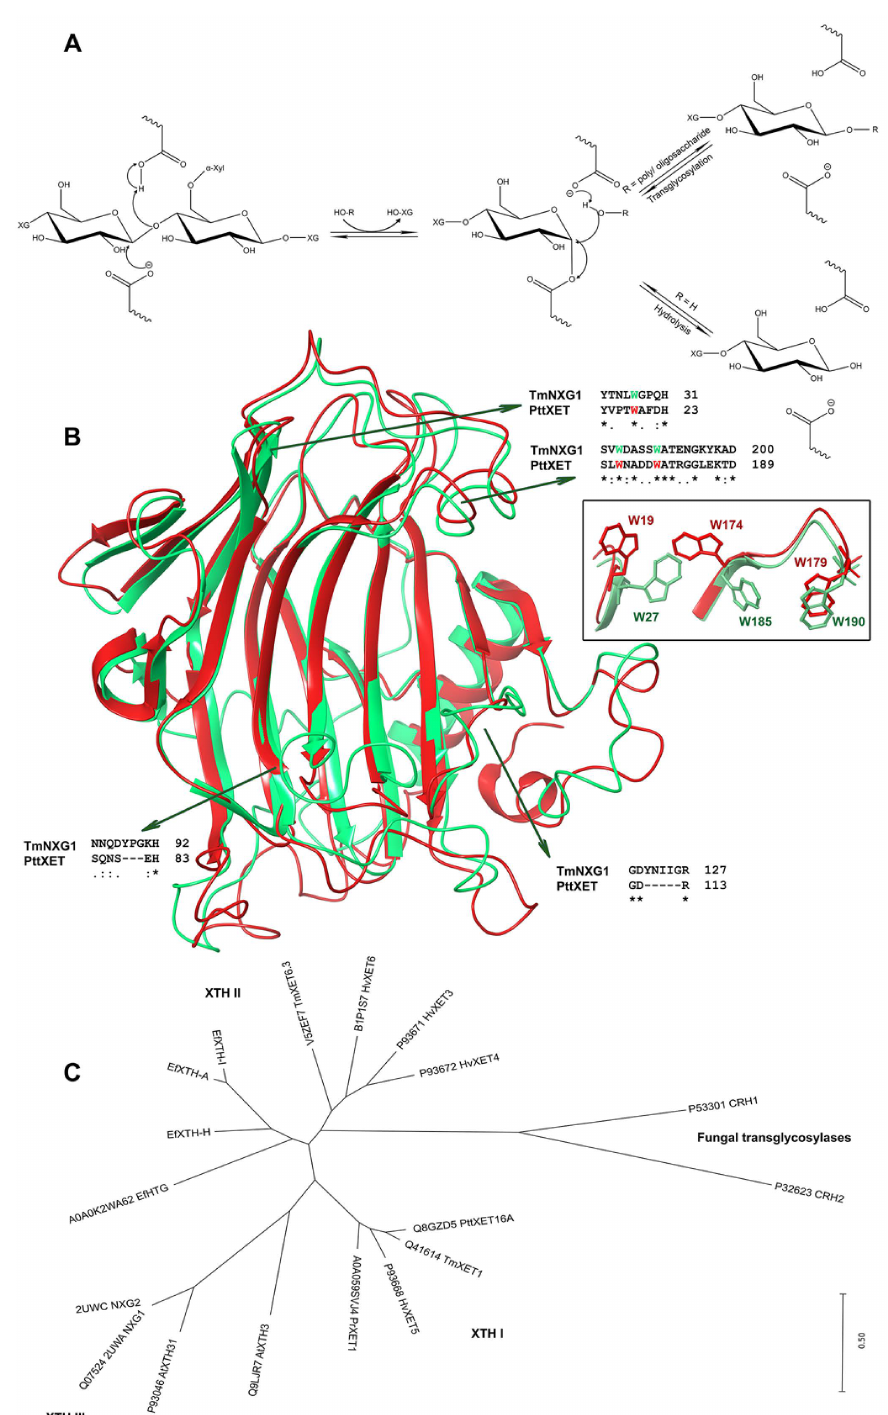
Figure 2. The GH16_20 subfamily of the XTH enzymes. ( A ) reaction mechanism [138] leading to transglycosylation or hydrolytic reactions; ( B ) superposition of the crystal structure of poplar PttXET16A transglycosylase (PDB accession 1UN1; red) and the nasturtium TmNXG1 hydrolase (green) [138,140] points to structural di ff erences that underlie their distinct activities; di ff erences in selected signatures that underlie these activities are indicated by sequence alignments, and some of these residues shown in the inset; ( C ) unrooted phylogenetic tree of the GH16 subfamily (MEGA v7.0.26; [141]) shows clustering of entries into three subgroups, where subgroups I and II consist of transglycosylases and subgroup III of hydrolases